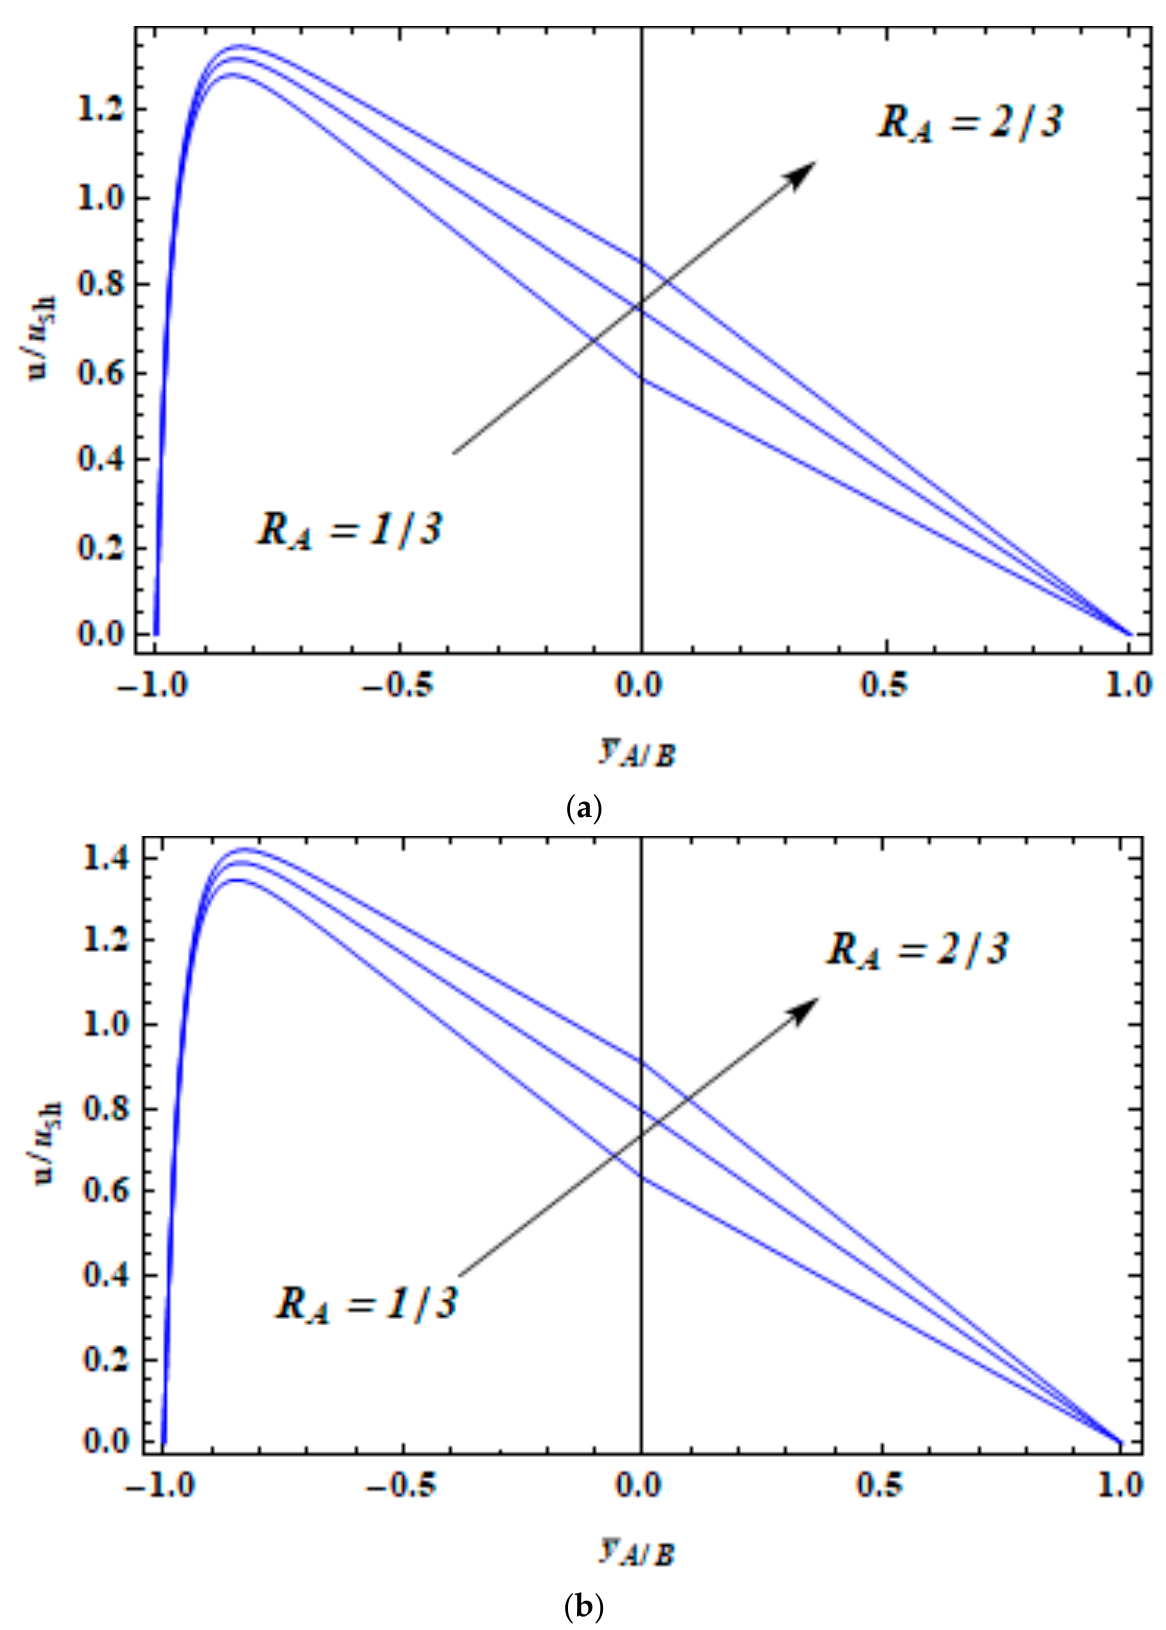
= 0.2; 𝑘 = 20; 𝑅 ( a ) β = 1; Γ = 0; R B = 0.2; k = 20; R ζ = 0; ( b ) β = 1; Γ = 0; R B = 0.2; k = 20; R ζ = (cid:3003)